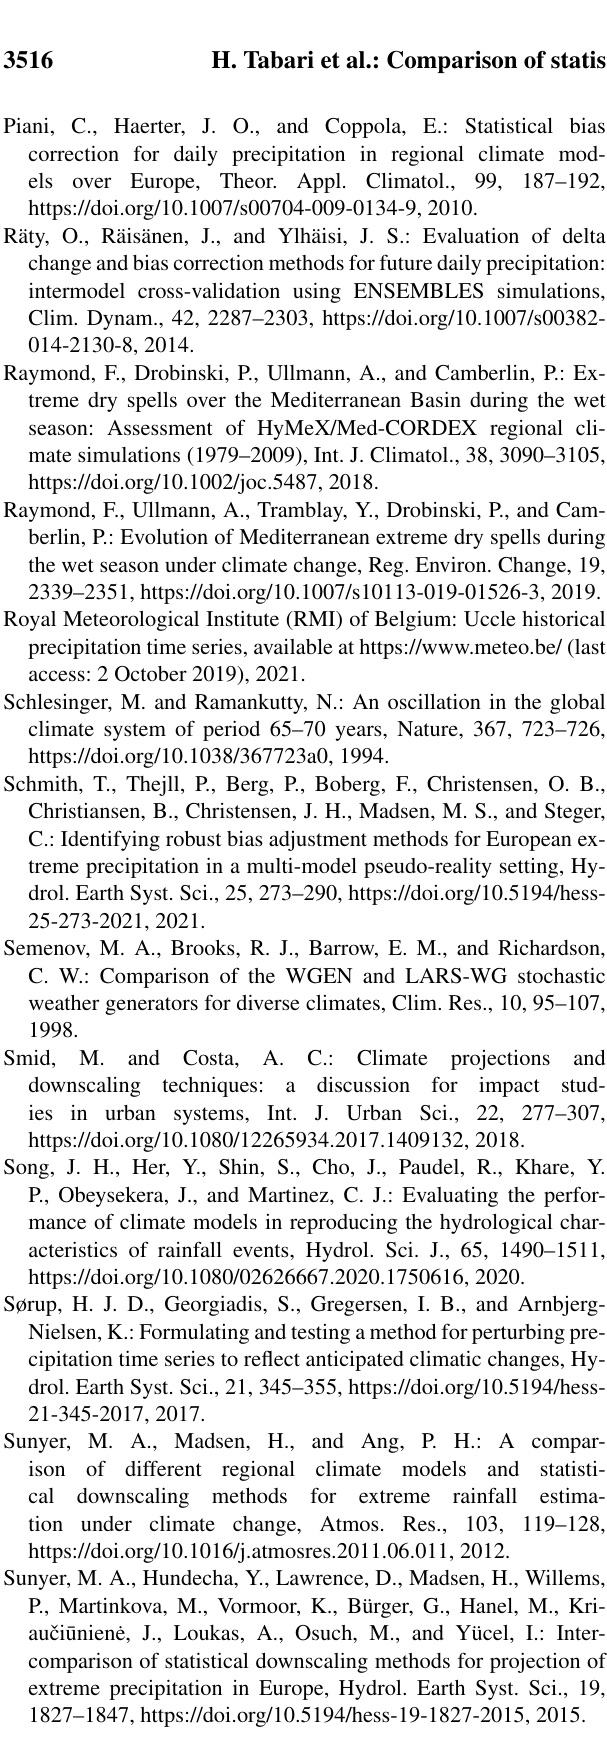
Tabari, H. and Willems, P.: More prolonged droughts by the end of the century in the Middle East, Environ. Res. Lett., 13, 104005, Tabari, H. and Willems, P.: Lagged influence of Atlantic and Pacific climate patterns on European extreme precipitation, Sci. Rep., 8, 5748, https://doi.org/10.1038/s41598-018-24069-9, 2018b. Tabari, H., Taye, M. T., and Willems, P.: Water avail- ability change in central Belgium for the late 21st century, Global Planet. Tabari, H., De Troch, R., Giot, O., Hamdi, R., Termonia, P.,